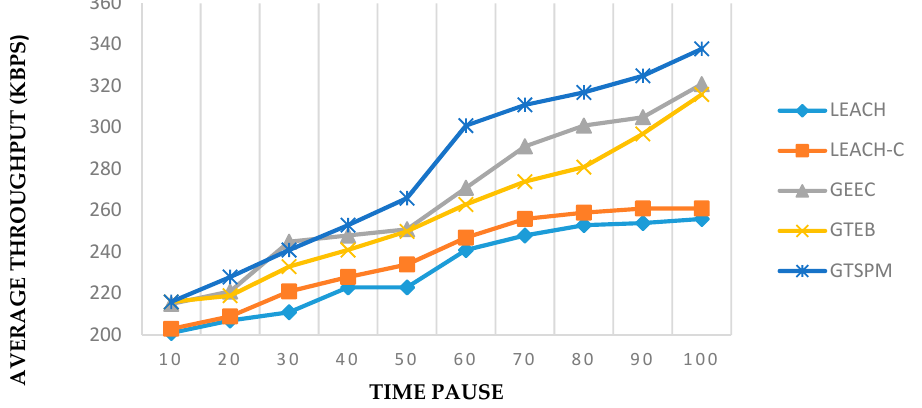
Figure 7. Throughput with time pauses (total nodes = 300).